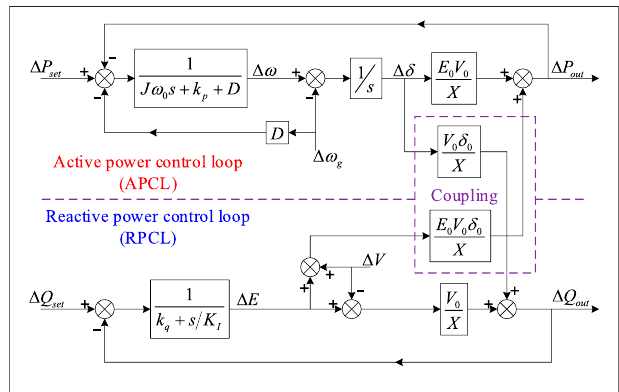
FIGURE 4 | Small-signal control